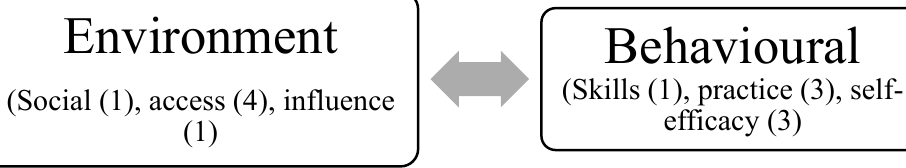
Figure 2. Social Cognitive Theory constructs used within the studies.